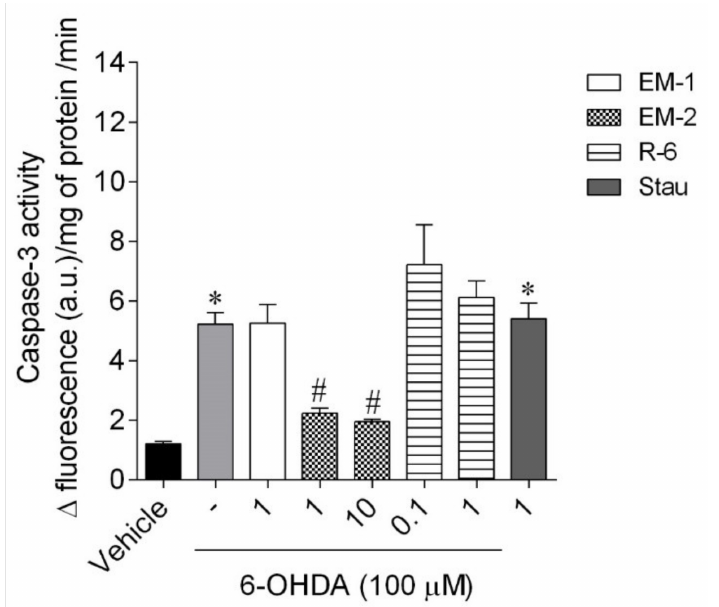
Figure 9. Caspase-3 activity of SH-SY5Y cells treated with 6-OHDA in the presence/absence of peptides (0.1–10 µ M, 6 h). The values in each column represent the mean ± standard error of the mean (SEM) of 3 or 4 independent experiments. Symbols represent significant differences (ANOVA, Dunnett’s test, p < 0.05) when compared to: * vehicle and # 6-OHDA. (-)